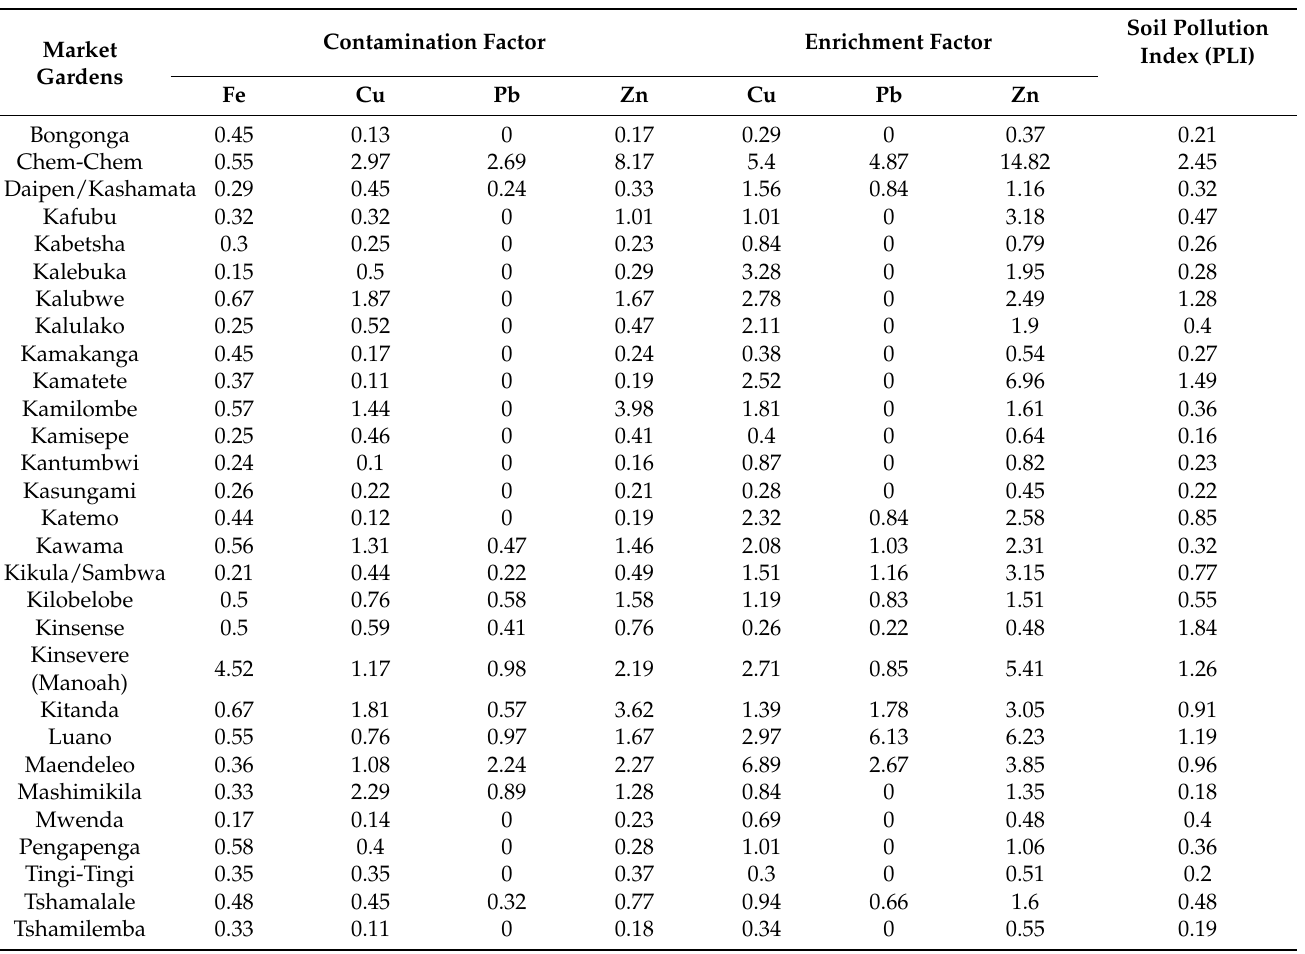
Table 3. Contamination, enrichment and pollution levels of the soils of 29 urban market gardens of